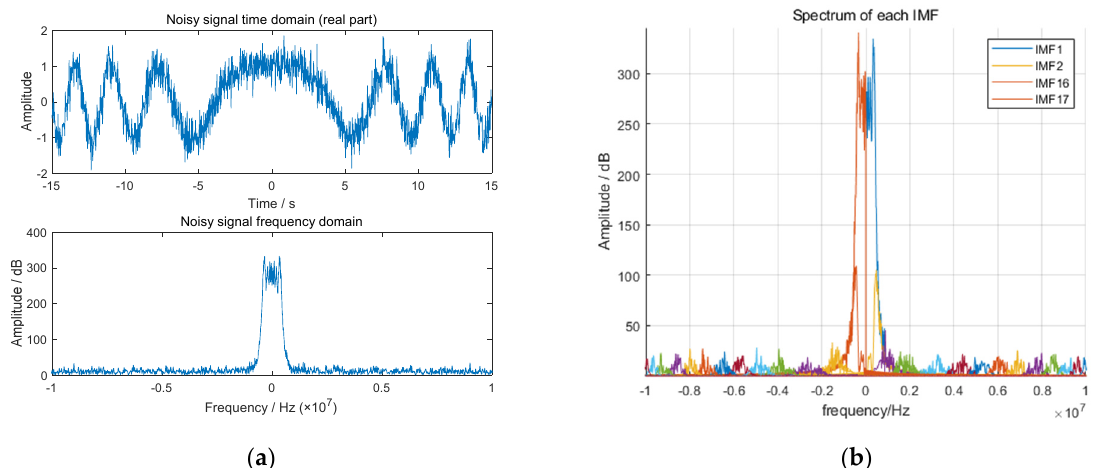
Figure 3. Noisy LFM signal decomposition results: ( a ) time domain and frequency domain diagram of noisy signal; ( b ) spectrum of IMF components.